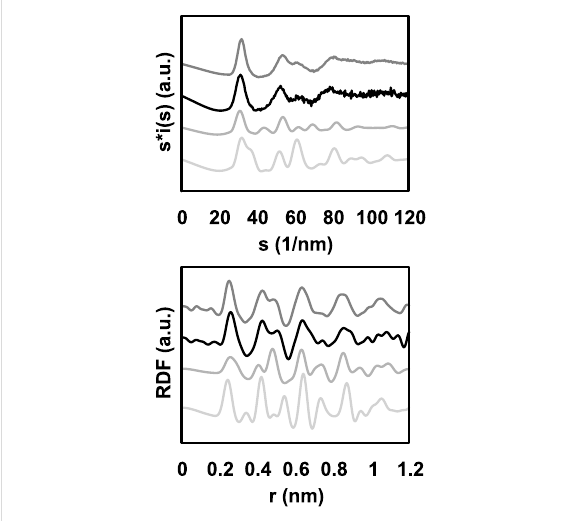
Figure 1: WAXS diagram (top) and the related RDF (bottom). Black: experimental spectra of Fe NPs taken at room temperature; dark grey (top): experimental spectra of Co NPs taken at room temperature; medium grey: α -Fe (bcc) model; light grey (bottom): γ -Fe (fcc) model.